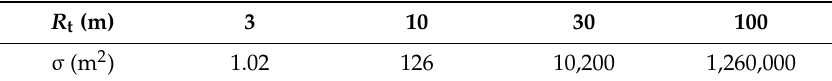
Table 4. Calculated values of an achievable RCS of targets at various ranges with a limited maximal TS output power equal to –20 dBm.